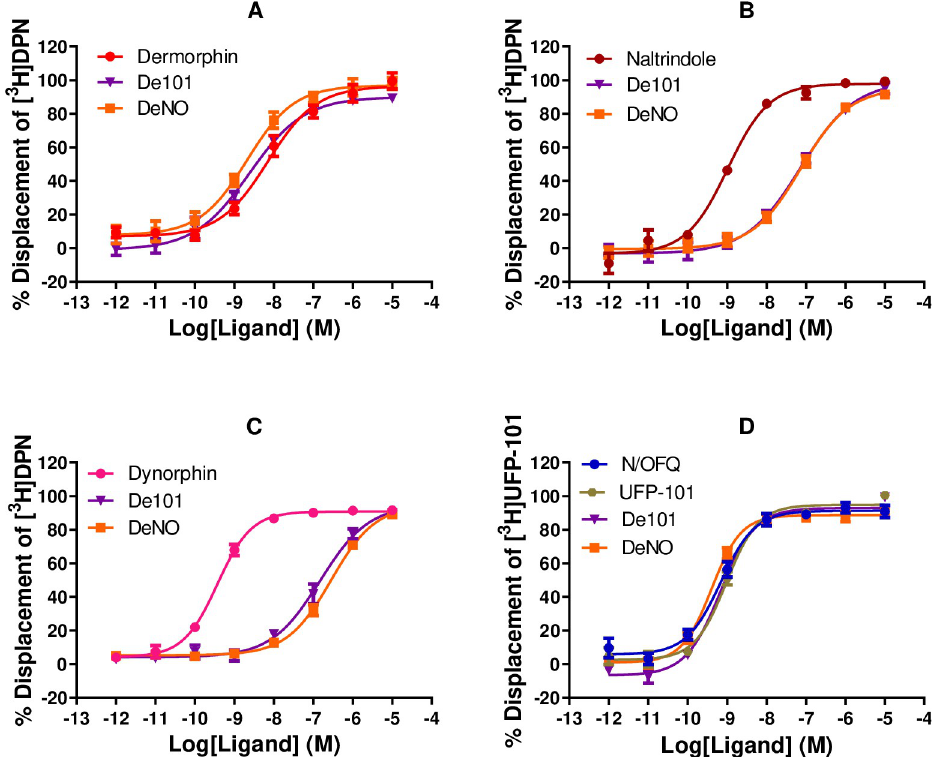
Fig 1. Displacement of [ 3 H]-DPN by Dermorphin and De101 and reference ligands at (A) CHO MOP , (B) CHO DOP , (C) CHO KOP and the displacement of [ 3 H]UFP-101 by De101 and N/OFQ at (D) CHO NOP cell membranes. Data are the mean ( ± SEM) of n = 5 experiments. DeNO curves are replicated from previous studies [14]. Reference ligands: Dermorphin; Naltrindole; Dynorphin-A; N/OFQ, (Nociceptin/Orphanin FQ).